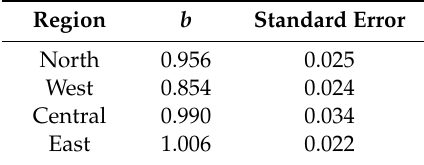
Table 6. Maximum likelihood estimates of the parameter b in the Gutenberg–Richter law in (1). Region b Standard Error North West 0.956 0.022 Central 0.022